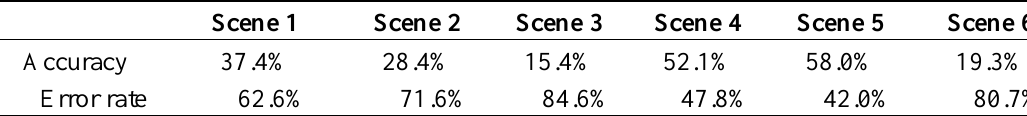
Table 7. Accuracies and error rates for each